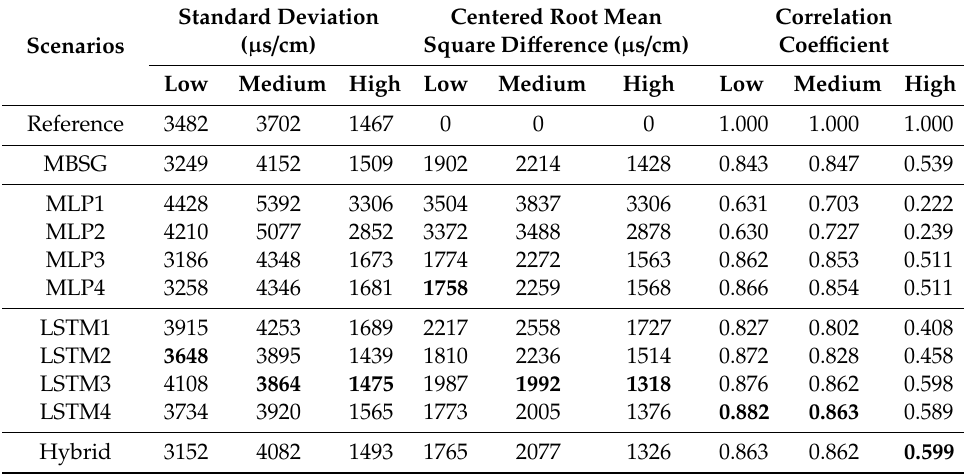
Table 3. Statistics of model-simulated Martinez salinity during three different salinity ranges.